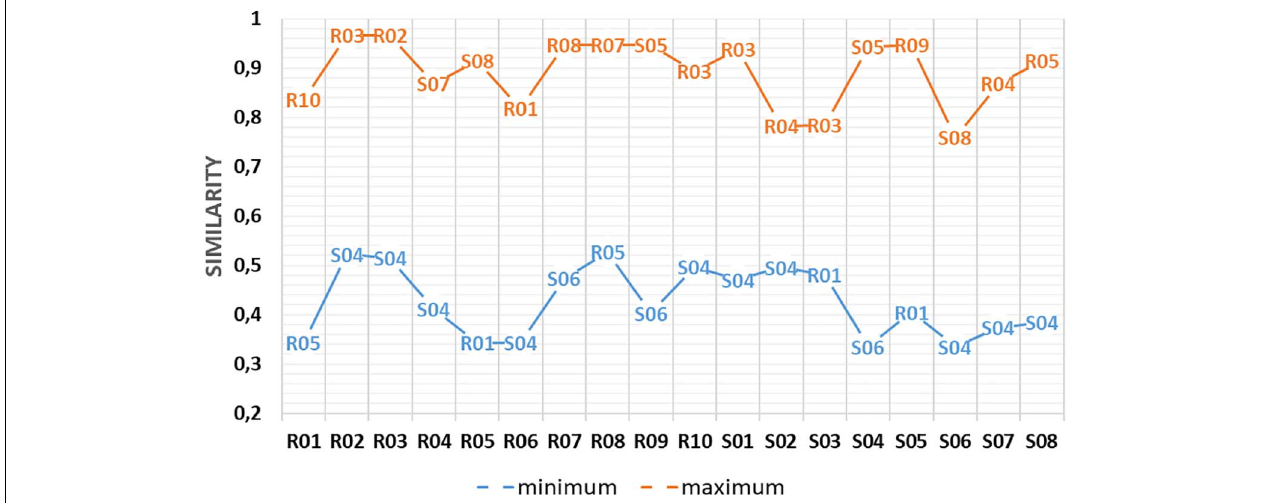
FIGURE 3 | The highest (top orange curve) and lowest (bottom blue curve) cosine-similarity (value on the y-axis) with other policies of each policy named on the x-axis (see Table 1 for the policy labels).